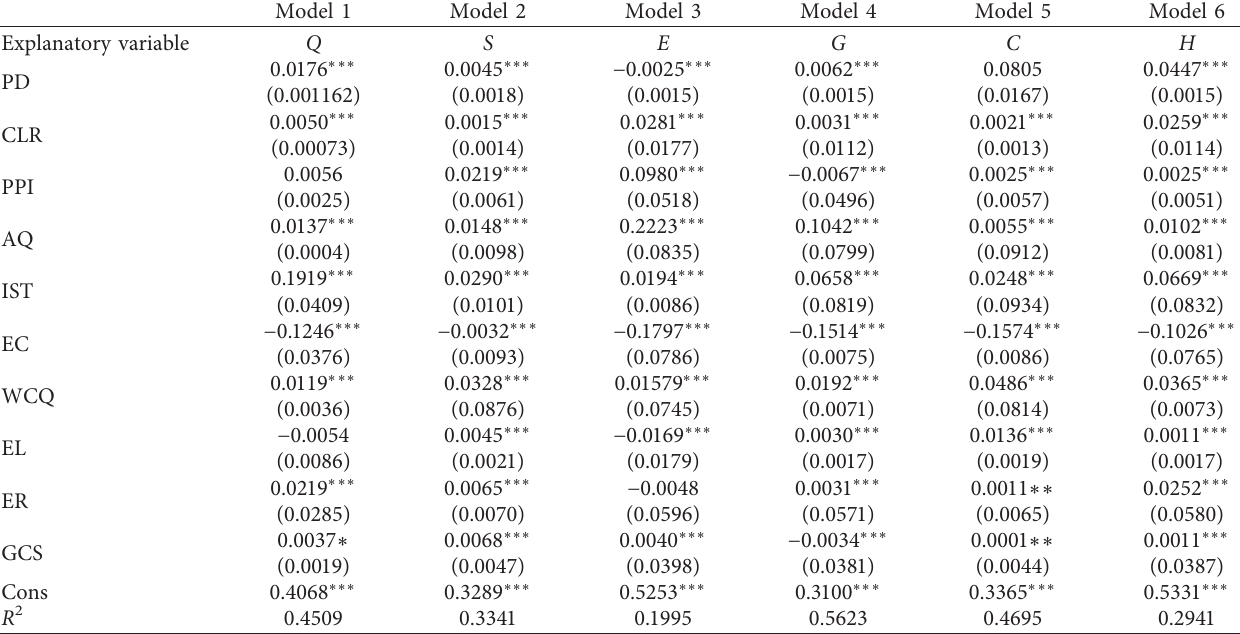
Table 2: Panel regression model results.